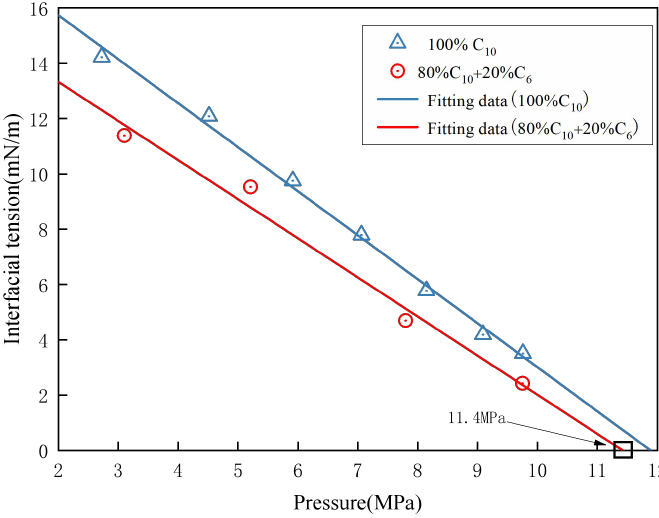
Figure 6 — Effect of oil composition on